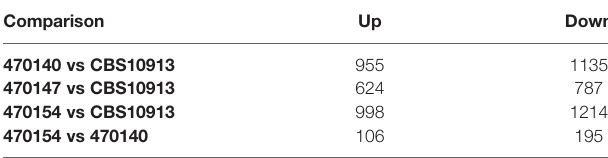
TABLE 1 | Number of differentially expressed genes